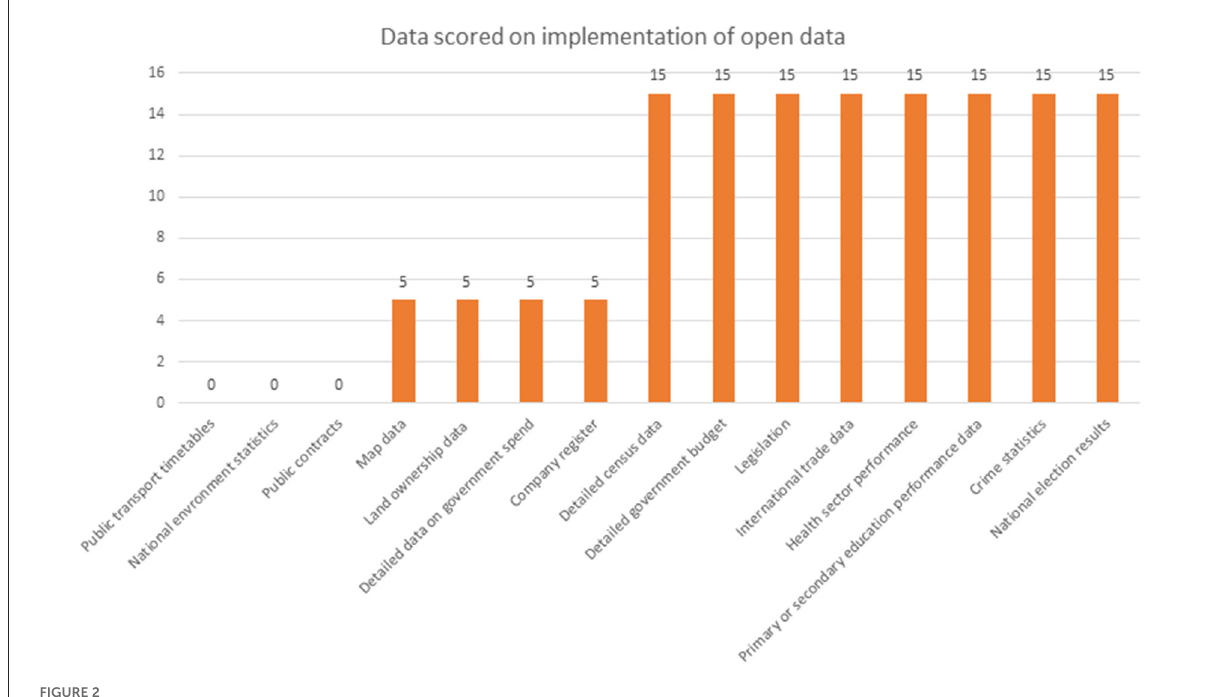
FIGURE2 Status of Zimbabwe in implementation of open data–Data source, Web Foundation (2018b).